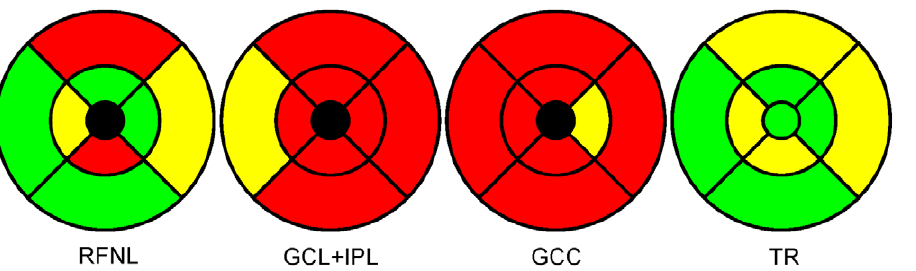
Figure 3. Regional differences between the non-affected eyes of MS patients and healthy eyes. The colors show the extent of thinning based on the p-values of the thickness comparisons. All representative numerical data are in Table 3. The color codes are as follows: red: p , 0.001, yellow: 0.001 , p , 0.05, green: p . 0.05. We note the central subfield (R1: black color) was excluded from the analysis for the layers which are not present in the foveal area. Abbreviations: GCC, ganglion cell complex; GCL + IPL, ganglion cell layer and inner plexiform layer complex; RNFL, retinal nerve fiber layer; TR, total retina.